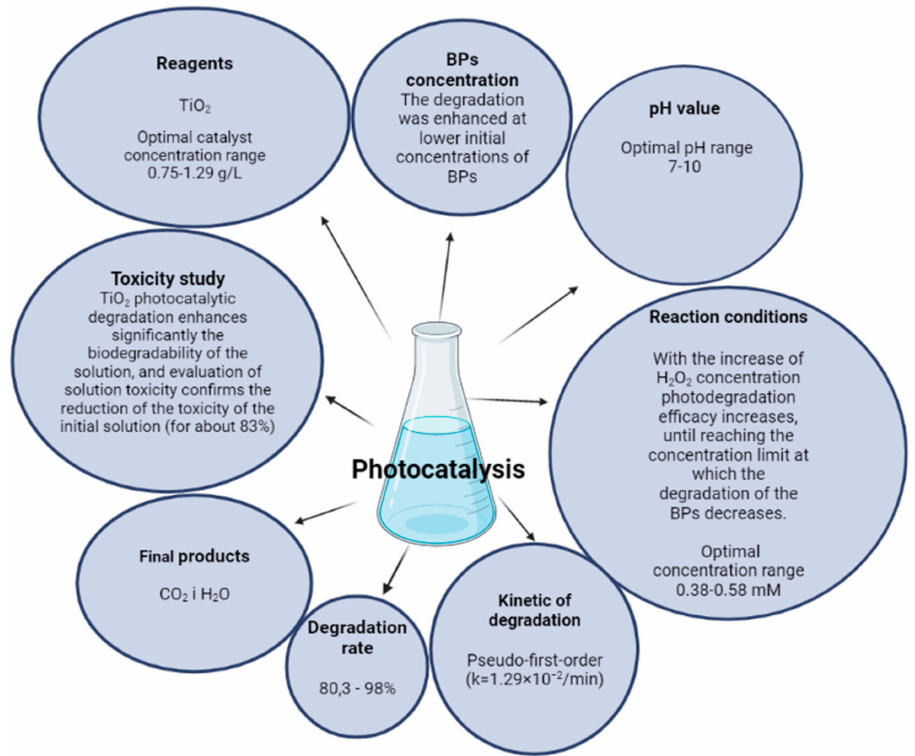
Figure 6. An overview of the effect of different conditions in the UV/TiO 2 photocatalytic system on the degradation process of BPs. Created in